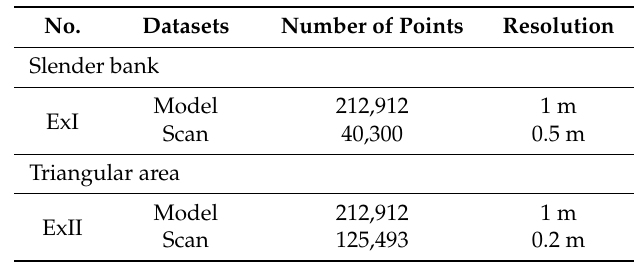
Table 1. Experimental conditions.